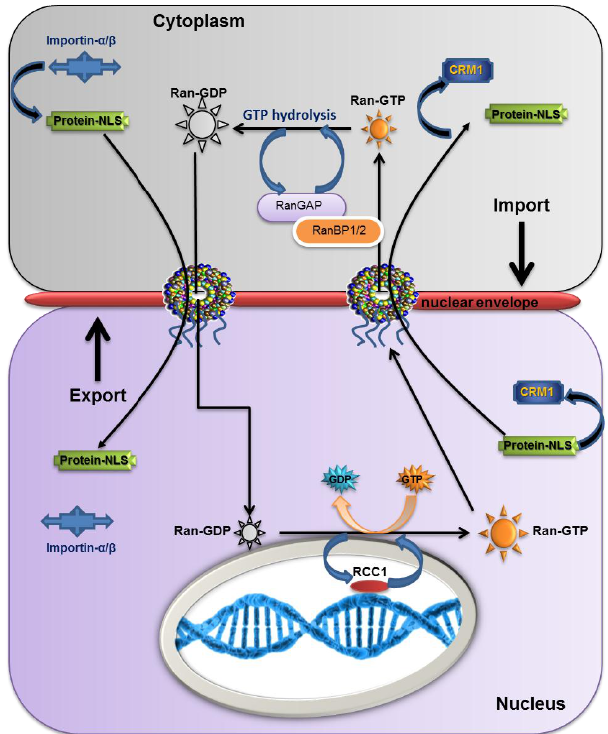
Figure 4. RanGTP Signalling. This diagram shows the overall mechanism of nuclear import and export. Ran assists in both of these processes by forming and dissociating complexes. This is also enabled by regulatory proteins RCC1, RanGAP, and RanBP1/2.